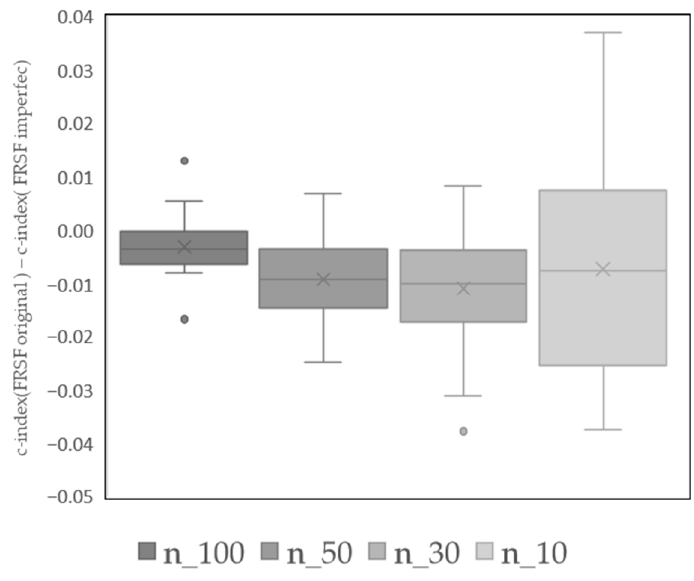
Figure 4. FRSF performance with noisy data in different datasets.